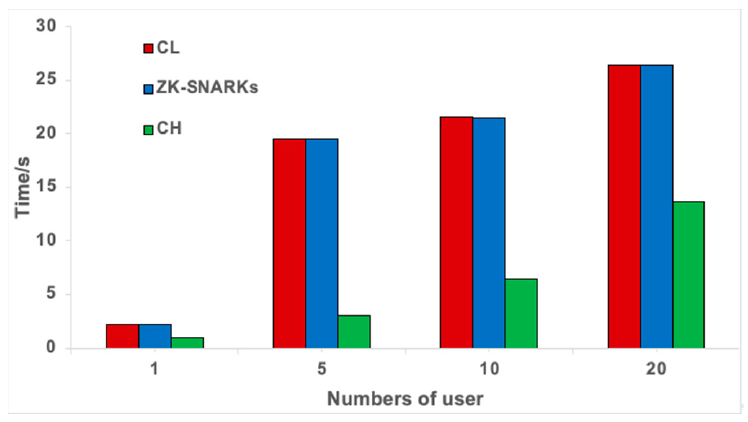
Figure 3. Comparison of signature verification time between CL, ZK-SNARKs, and CH.